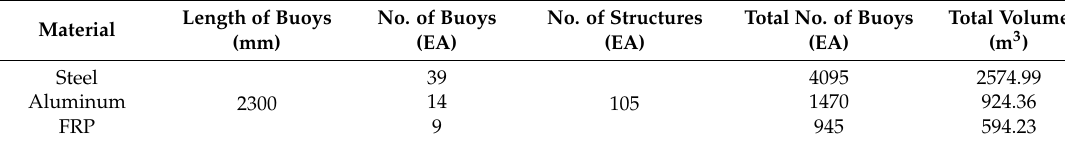
Table 11. Results of the floating